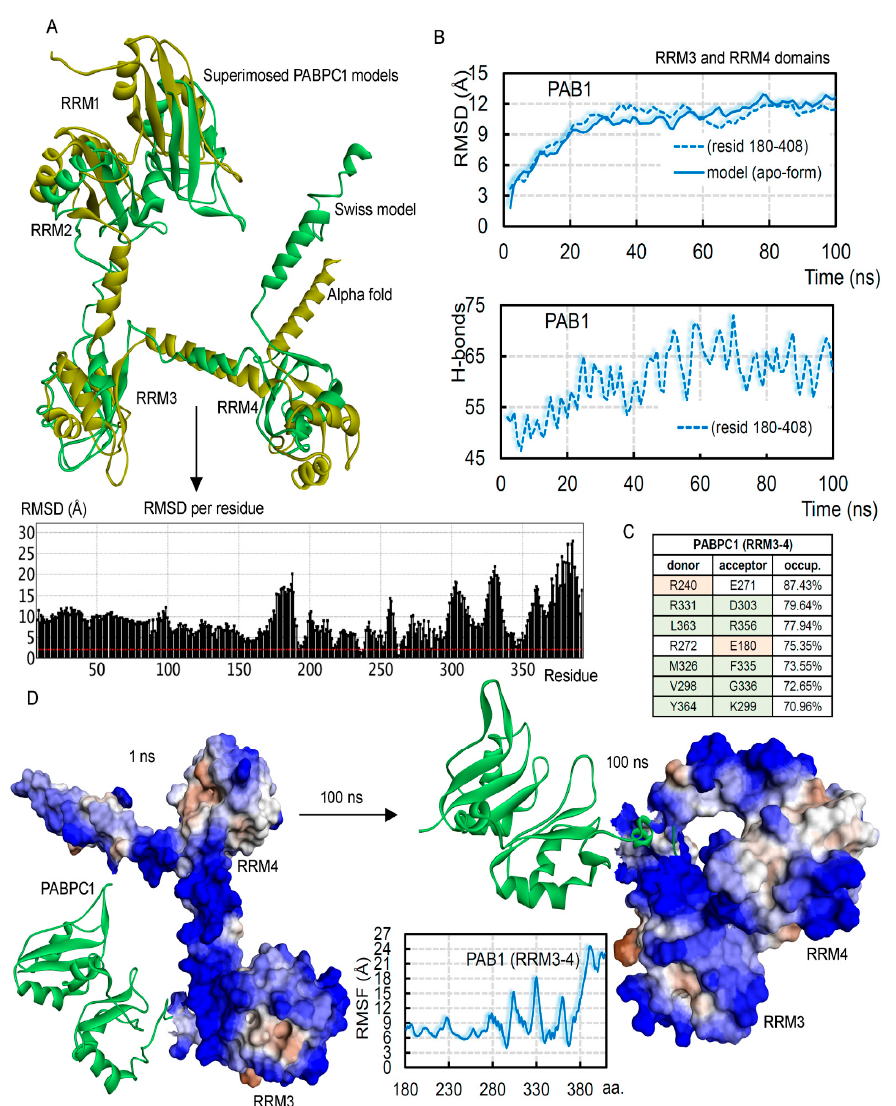
Figure 3. The RRM3–4 domains from the PAB1 and PABPC1 protein. ( A ) Our studied model of PABPC1 structure (generated using SWISS-MODEL [16,17]) superimposed with the structure generated by the “Alpha Fold” tool [21]. The below graph represents the RMSDs of individual residues when compared with both models. Structures were superimposed using the MOE (Chemical Computing Group Inc., Montreal, QC, Canada) pipeline. ( B ) The RMSDs of RRM3–4 domains from the molecular dynamics simulation were computed from the simulated PABPC1 apo-form structure. The below graph represents intramolecular interactions within the PABPC1 apo-form for the region 180–408 aa consisting of the RRM3–4 domains. ( C ) High-occupancy intramolecular interactions from the PABPC1 protein reside in RRM3 (orange background) and RRM4 (green background). ( D ) Conformational change in the PABPC1 apo-form and the hydrophobicity (blue for hydrophilic and brown for hydrophobic) also showed significant fluctuations. The center plot represents the RMSFs for the residue in the RRM3–4 domains.